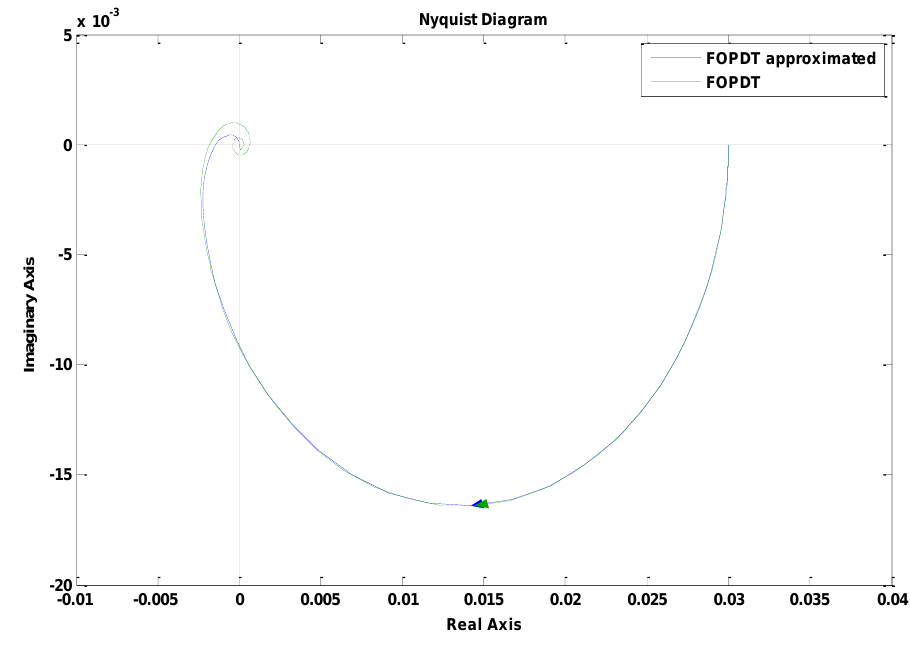
Figure 5. Bode plot comparison of G(s) and G Pade’s (s)